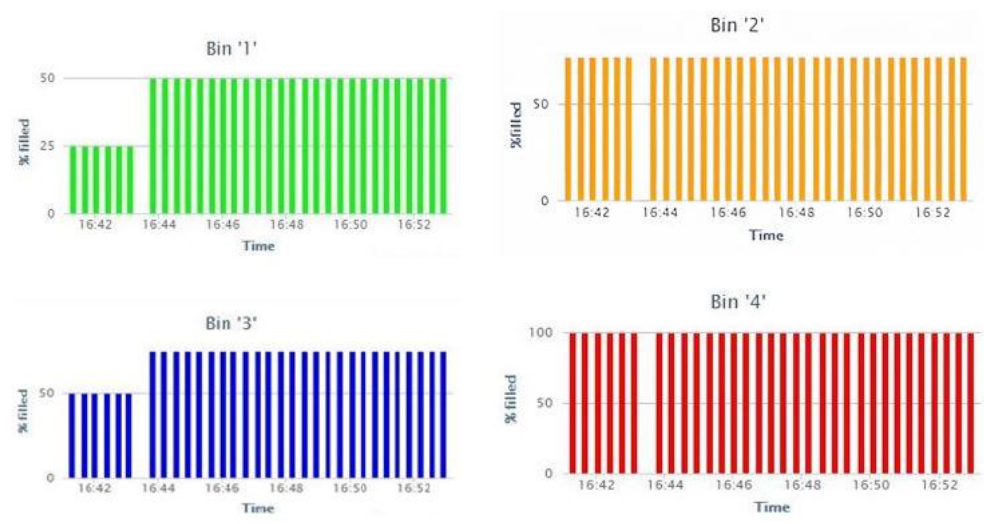
Figure 14. Bin status on the cloud